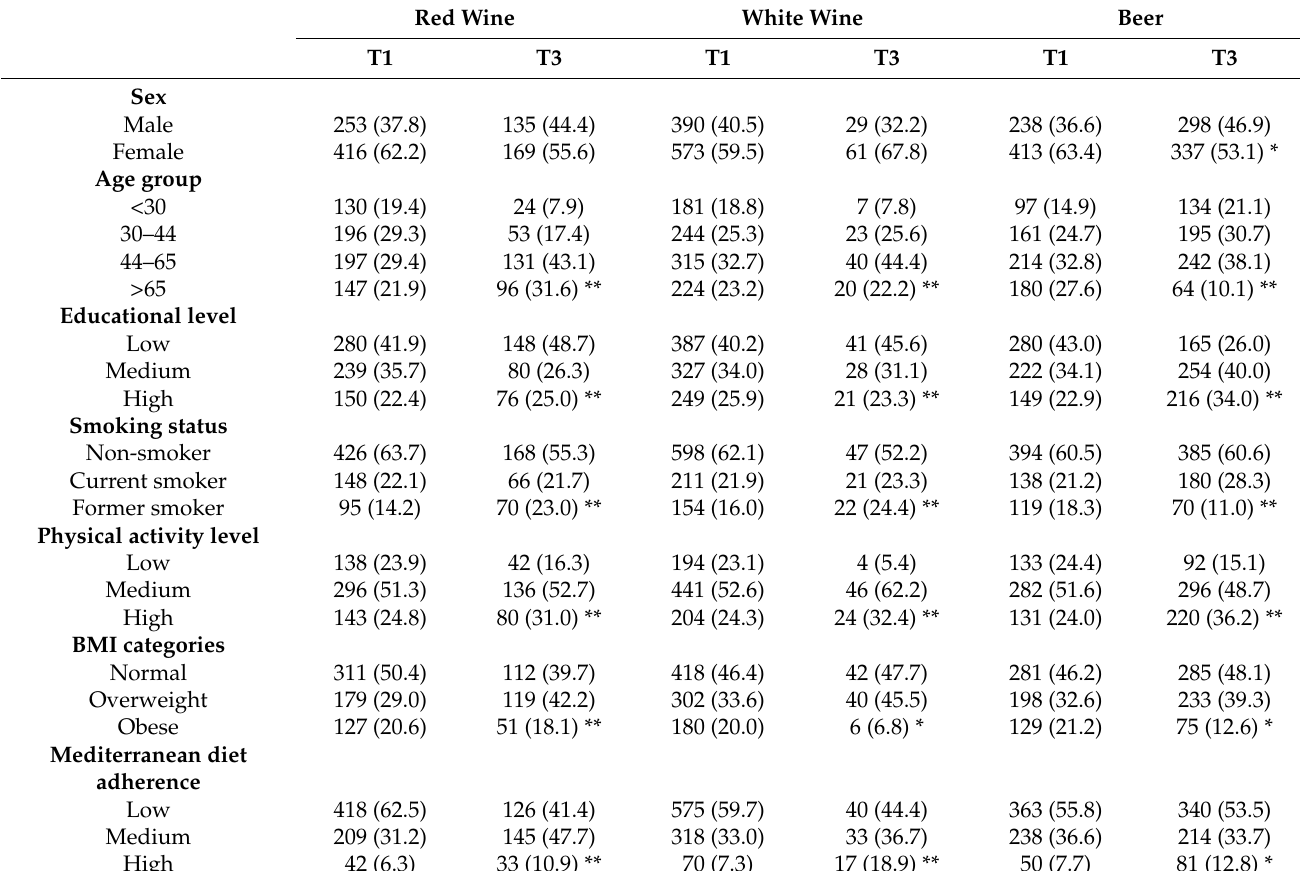
Table 2. Background characteristics of the study sample by consumption of individual alcoholic beverages contain- ing